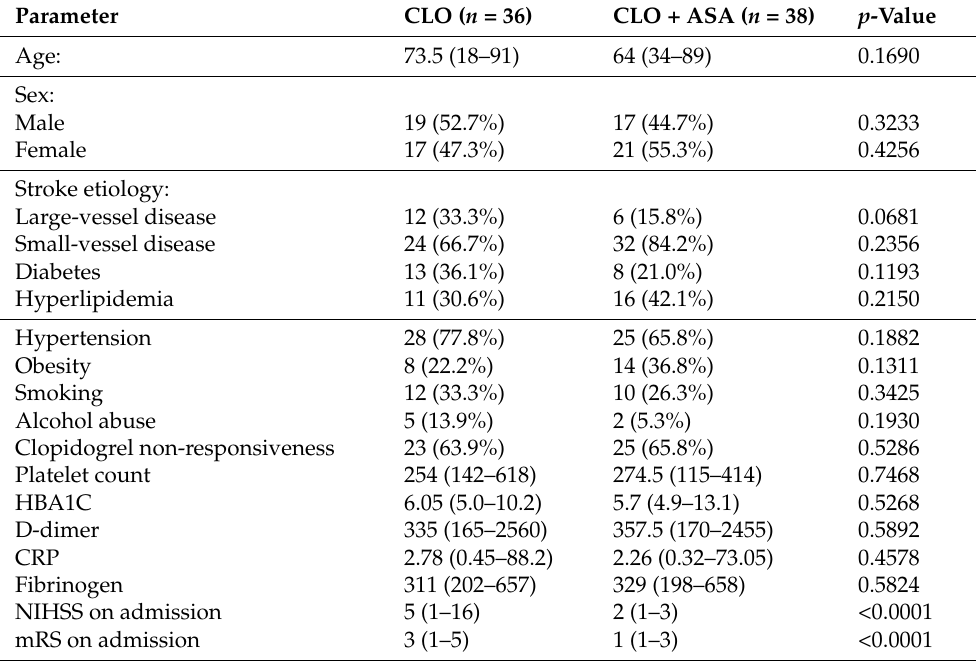
Table 1. Comparison of the baseline characteristics of the groups with a single and dual an- tiplatelet